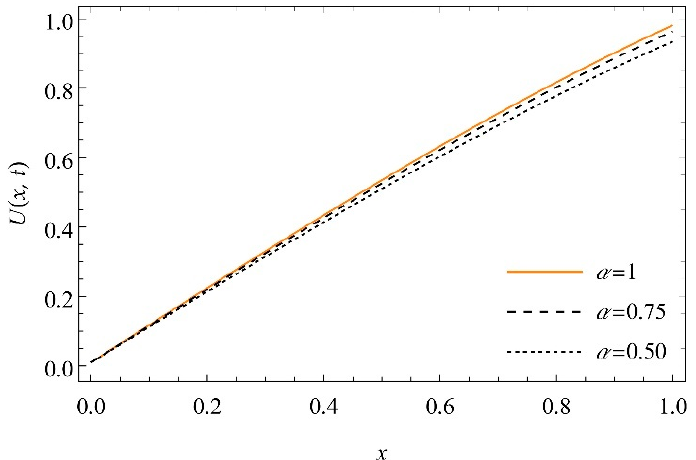
Figure 4. The graph of 𝑈(𝑥, 𝑡) versus depth 𝑥 at 𝑛 = 1, 𝑡 = 0.1 , and for 𝛼 = 1, 0.75, 0.50 for